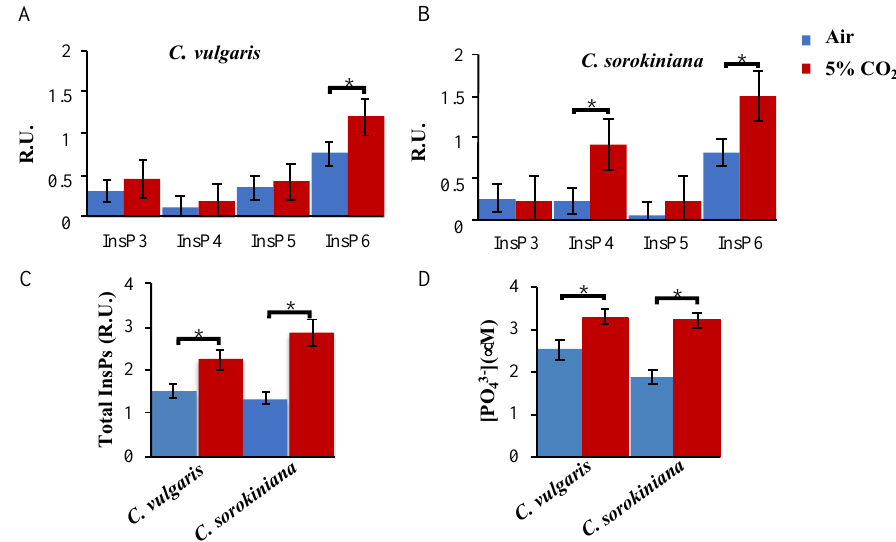
Figure 2. Accumulation of InsPs and orthophosphate under 5% CO 2 concentration in Chlorella strains: ( A , B ) Inositol polyphosphate (InsP 3 , InsP 4 , InsP 5 and InsP 6 ) levels in the two Chlorella strains under air or 5% of CO 2 . ( C ) Total InsPs levels under the same conditions and strains. ( D ) Total orthophosphate concentration in cell samples of C. sorokiniana and C. vulgaris under the same mentioned conditions. The mean ± SE was calculated from three independent biological replicates performed in triplicate. The measurements were performed as indicated in the Methods section. * represent significant differences ( p < 0.05) evaluated using Student’s t test.